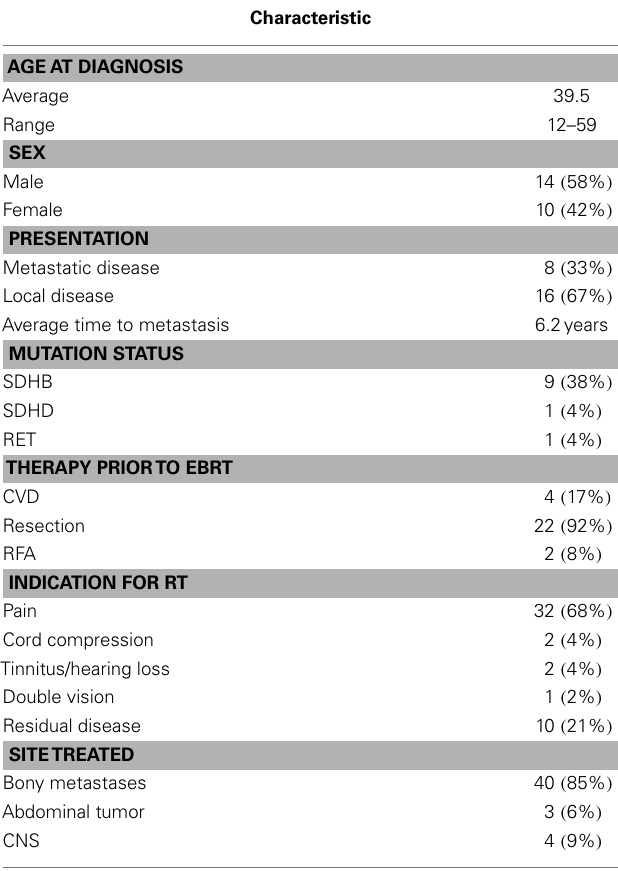
Table 2 | Patient characteristics